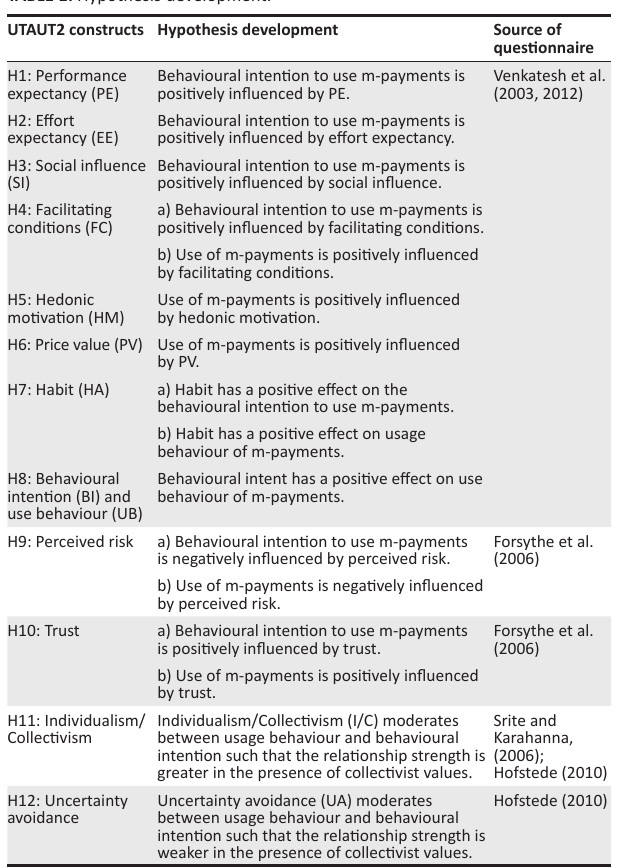
TABLE 1: Hypothesis